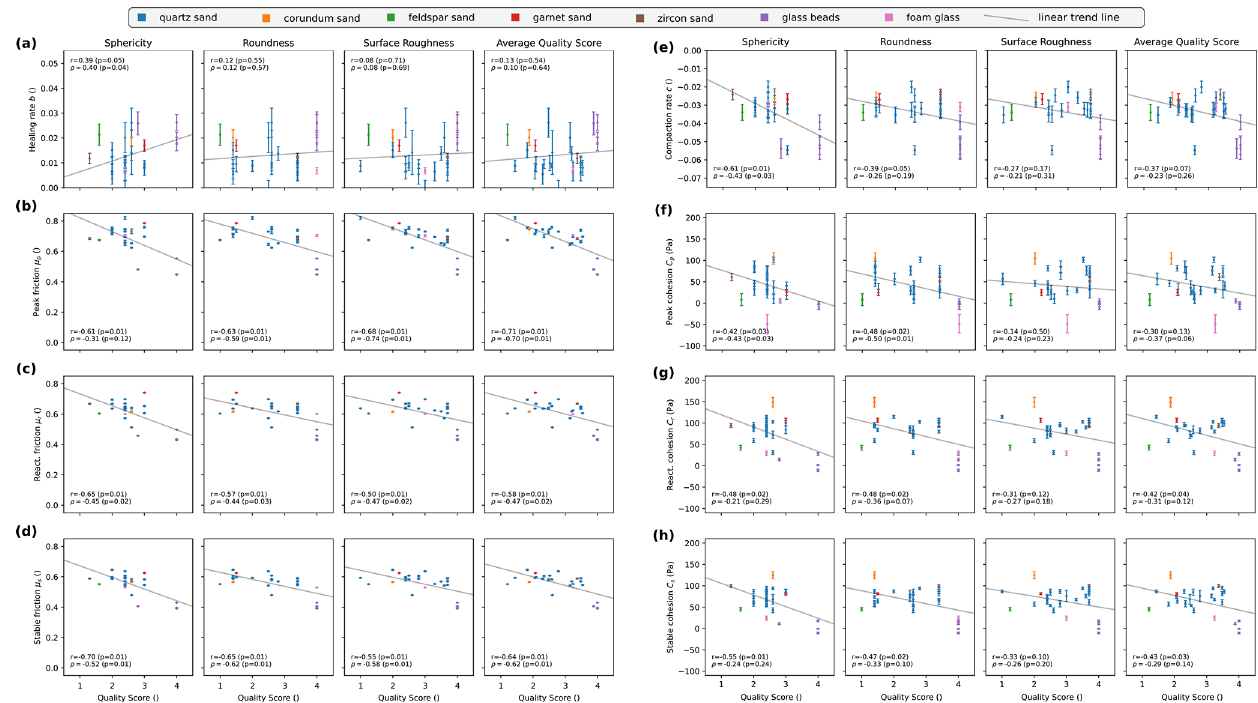
Figure 7. Correlation of frictional properties with quality score: (a) healing rate, (b) – (d) friction coefficient, (e) compaction rate, and (f) – (h) cohesion. The grey lines are simple linear fits of the data to highlight the trends in the datasets. They are not necessarily of statistical